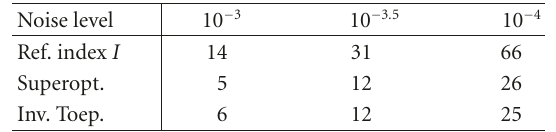
Table 5: Number of iterations required for a large image. Mask 3, with τ = 0 . 1 for (cid:14) = 10 − 3 , τ = 0 . 08 for (cid:14) = 10 − 3 . 5 , and τ = 0 . 06